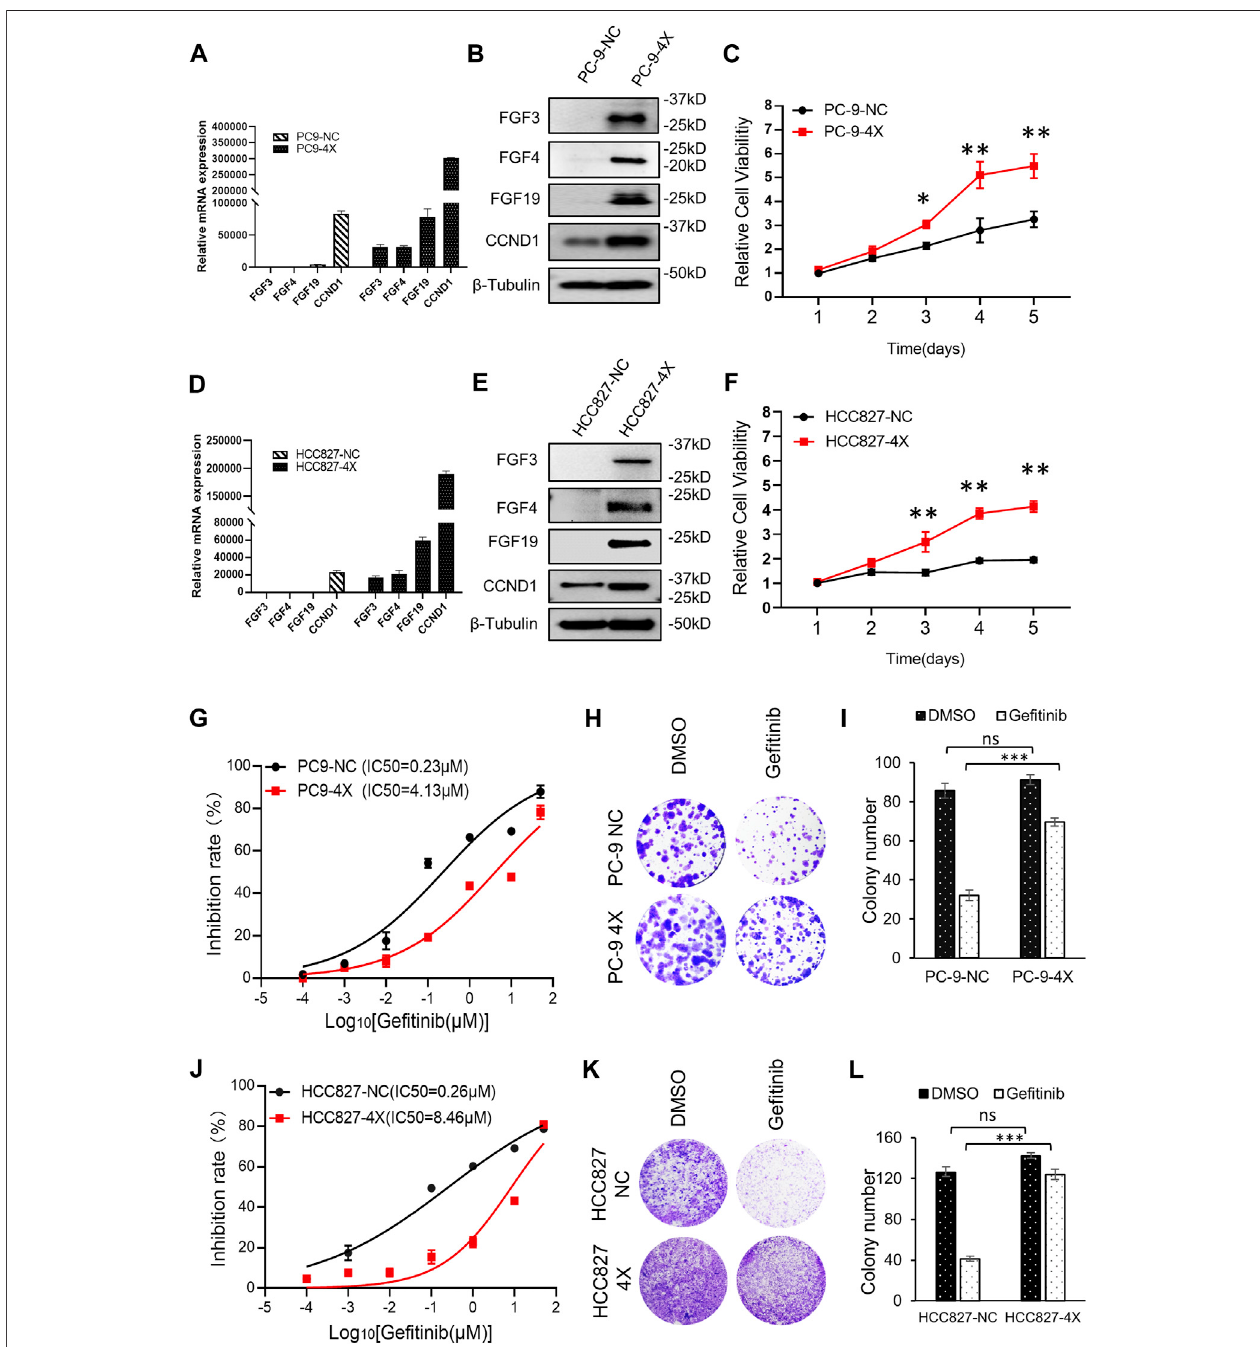
FIGURE 1 | FGF3/4/19/CCND1 promotes ge fi tinib resistance. (A,B) PC-9 cells were transduced with FGF3/4/19/CCND1(4X) or empty vector (negative control, NC) by lentivirus transduction. The gene expressions were con fi rmed by qRT-PCR (A) and Western blot (B) . Error bars indicated standard deviation (SD), n = 3. (C) Cell viability assay. PC-9 cells were seeded in 96-well plates (2,000 cells/well). CCK8 assay was applied to measure the cell viability ( p values re fl ected comparison to the controlsamplesofindicatedtimepoints.* p < 0.05.** p < 0.01). (D,E) HCC827cellsweretransducedwithFGF3/4/19/CCND1(4X)oremptyvector(negativecontrol, NC) by lentivirus transduction. The gene expressions were con fi rmed by qRT-PCR (D) and Western blot (E) . Error bars indicated SD, n = 3. (F) Cell viability assay. HCC827 cells were seeded in 96-well plates (2,000 cells/well). CCK8 assay applied in indicated time to measure the cell viability ( p values re fl ect comparison to the controlsamplesofindicatedtime points.* p < 0.05. ** p < 0.01). (G) Theinhibition rate ofge fi tinib inPC-9 cellswasmeasured byCCK8assayfollowingge fi tinibtreatment for 72 h. Each experiment was performed in triplicate. (H) Colony formation assay. Cells were treated with DMSO or ge fi tinib for 14 days. The remaining cells were stained with 0.1% crystal violet and photographed. Each experiment was performed in triplicate. Representative wells were shown. (I) Colonies of remaining cells were counted. Error bars indicated SD. (J) Inhibition rate of ge fi tinib in HCC827 cells was measured by CCK8 following ge fi tinib treatment for 72 h. Each experiment was